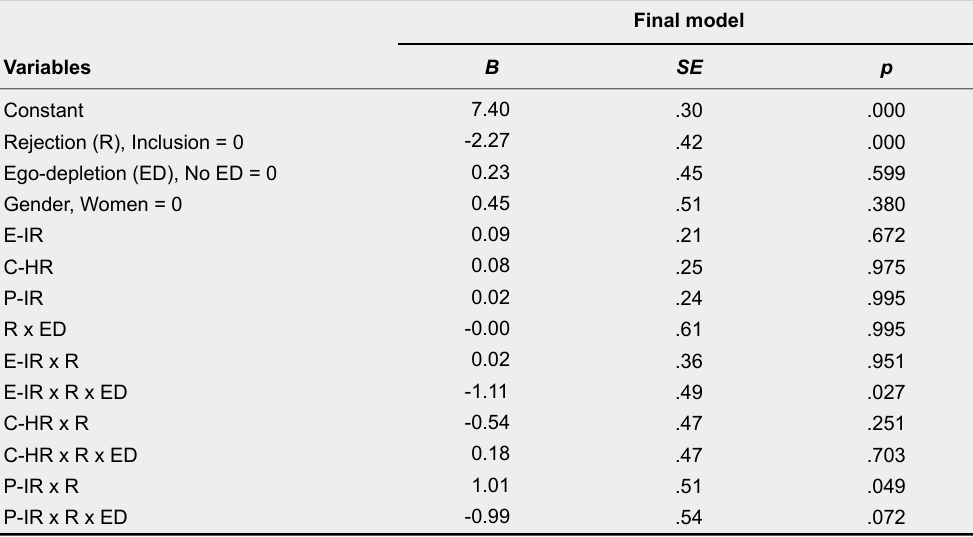
Hierarchical Multiple Regressions Models for Readiness for Aggression on Retaliatory Aggressive Behavior (the More Positive Evaluation was Granted the Less